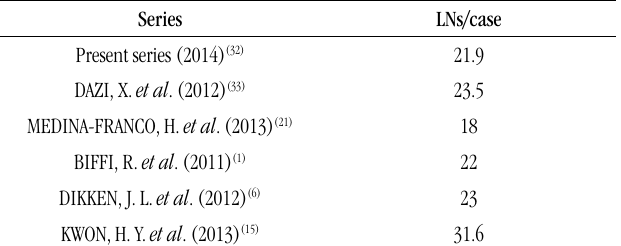
tABLE 4 − Average number of lymph nodes obtained by conventional method in different series of gastric